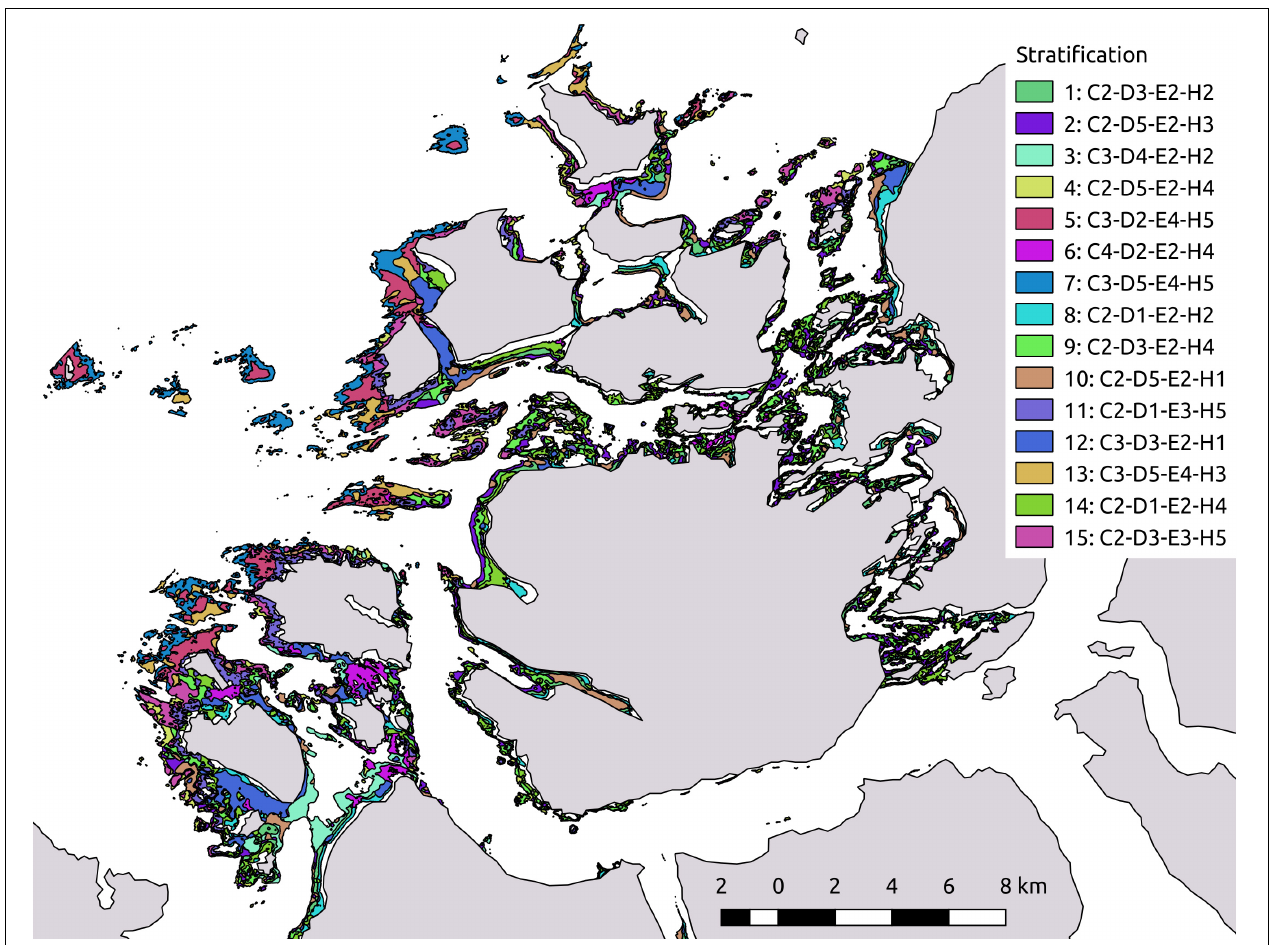
FIGURE 3 | Map of stratification result from kmeans analysis. The stratification resulted in 15 strata that were used in the planning of sampling strategy. In an attempt to describe the environmental conditions of each stratum, the strata exhibited a code with combinations of four letters C (bottom Currents), D (Depth), E (wave Exposure/height), and H (proportion Hard substrate); and four numbers taking the values 1 (representing values between the 0 and 20 percentile for the environmental covariate in question), 2 (21 and 40 percentile), 3 (41 and 60 percentile), 4 (61 and 80 percentile), and 5 (81 and 100 percentile).